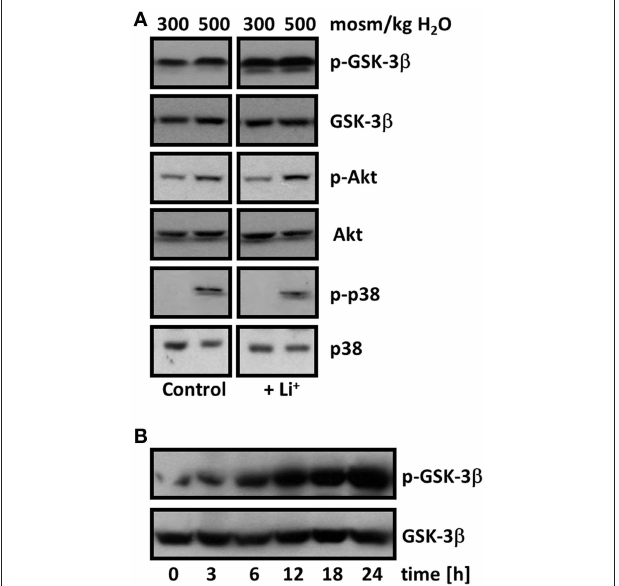
FIGURE 4 | Lithium mediates inhibitory phosphorylation of GSK-3 β . (A) Confluent IMCD-3 cells were incubated for 24h in isosmotic (300 mosm/kg H 2 O) or hyperosmotic (500 mosm/kg H 2 O) medium and exposed to 10mM Li 2 SO 4 or 10mM Na 2 SO 4 (as control). Thereafter, cells were processed for immunoblotting and phosphorylation status of GSK-3 β , AKT, and p38 was determined as described in Methods. A representative blot from four independent experiments is shown. (B) Time-course of GSK-3 β inhibitory phosphorylation. Confluent IMCD-3 cells were incubated for 0–24h in isosmotic medium (300 mosm/kg H 2 O) in the presence of 10mM Li 2 SO 4 . Thereafter, cells were processed for immunoblotting and phosphorylation status of GSK-3 β was determined as described in Methods. A representative blot from four independent experiments is